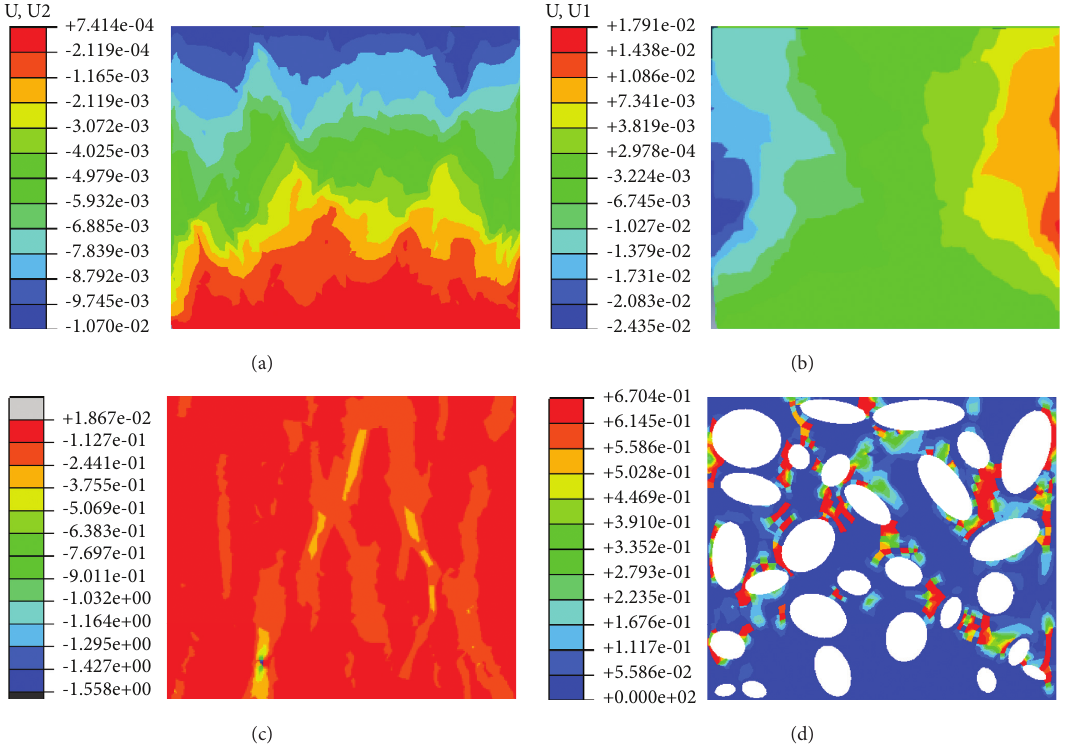
Figure 15: Model 5 simulation results: (a) displacement diagram in U2 direction, (b) displacement diagram in U1 direction, (c) axial stress diagram, and (d) damage